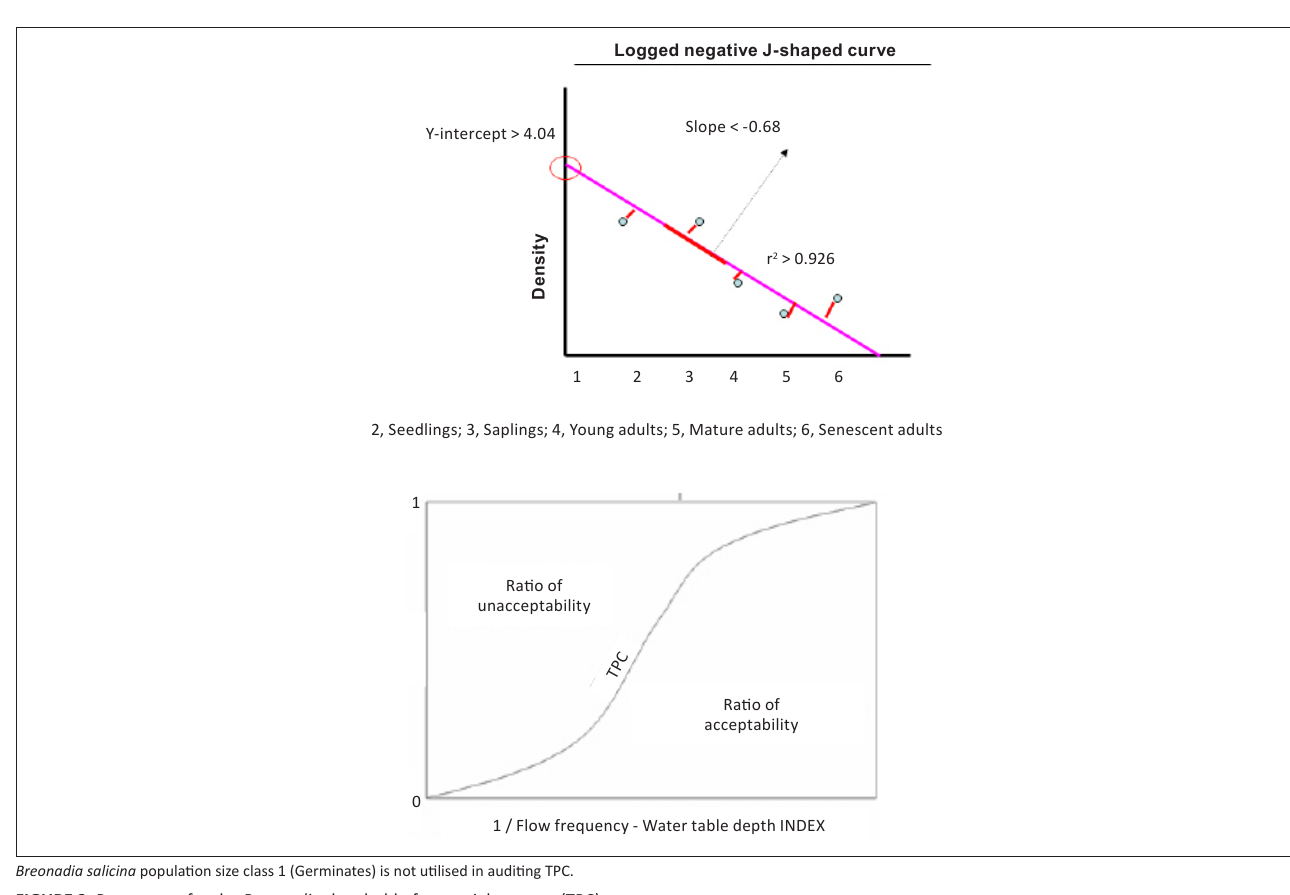
FIGURE 3: Parameters for the Breonadia threshold of potential concern (TPC).